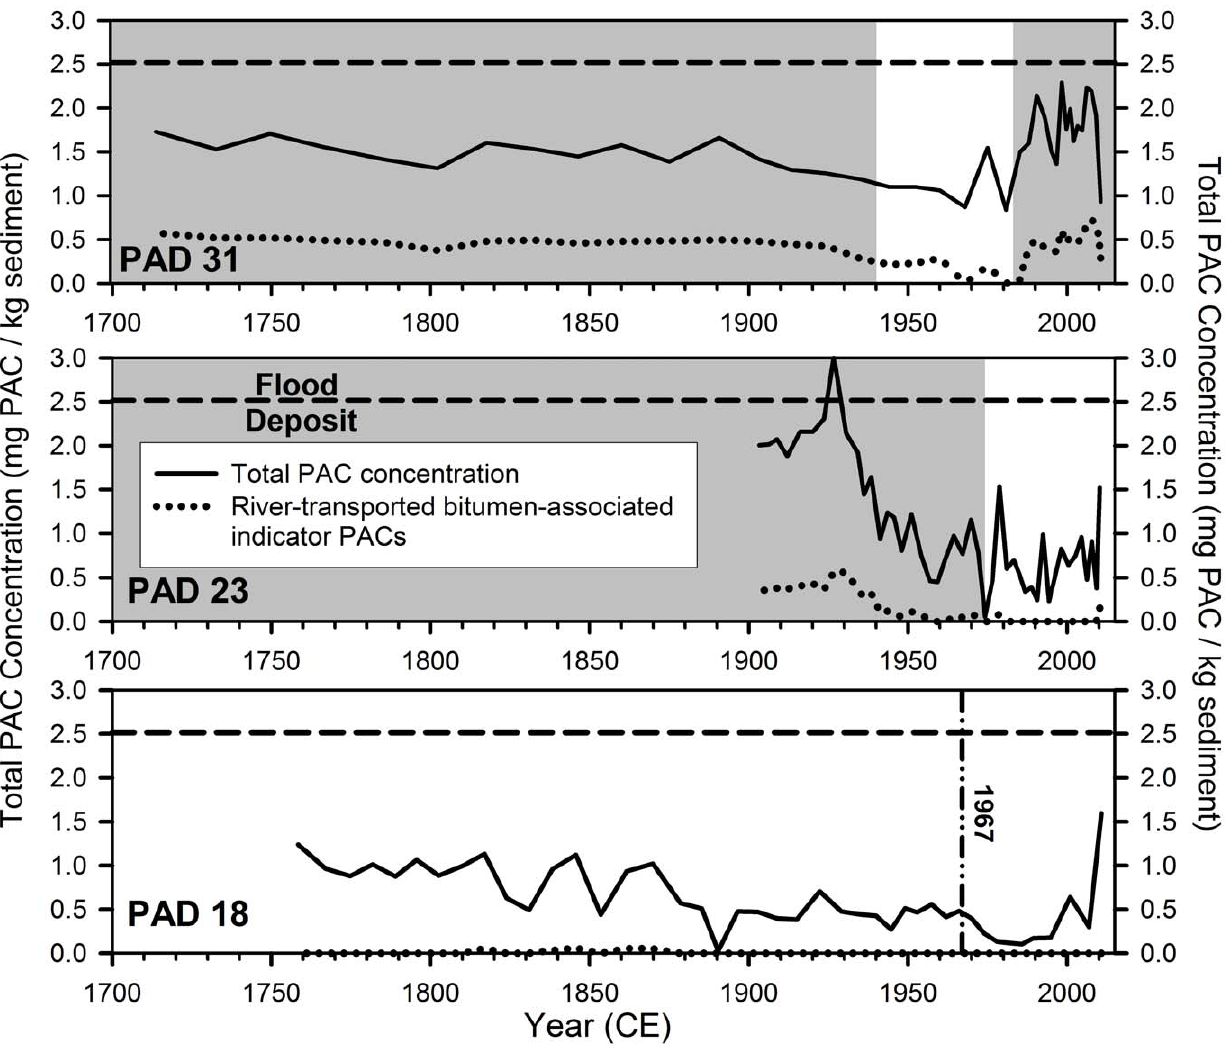
Figure 8. Time trends of total PAC concentration. Stratigraphic records showing the total PAC concentration (solid line) and the concentration of the seven PACs indicative of a bitumen origin and transport by the Athabasca River (dotted line) in the sediment cores from lakes PAD 31, PAD 23 and PAD 18. Grey shading identifies periods when the lakes were flood-prone. Absence of shading identifies periods when the lakes were not flood- prone. The vertical dashed-dotted line in the plot for PAD 18 identifies 1967, the year when major commercial oil sands operations began [1,4]. The dashed horizontal line in all three panels corresponds to the average value for the total PAC concentration in the 2007 Athabasca Delta flood deposits (2.518